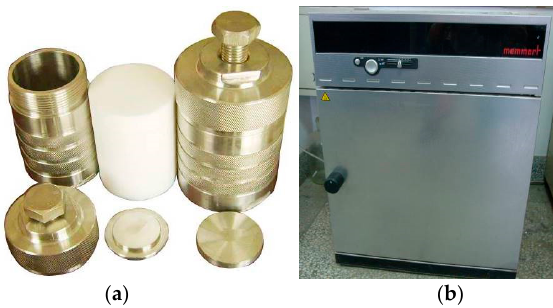
Figure 2. Images of the Teflon-lined stainless steel autoclaves ( a ) and an oven with temperature control ( b ) typically applied for the hydrothermal generation of CPs.